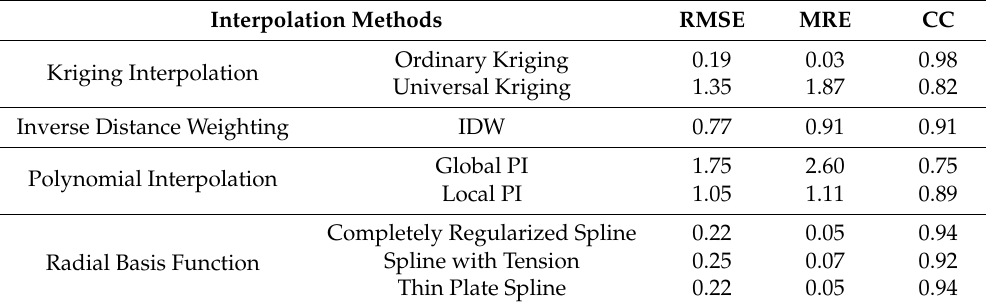
Table 1. Comparison of different geo-spatial interpolation